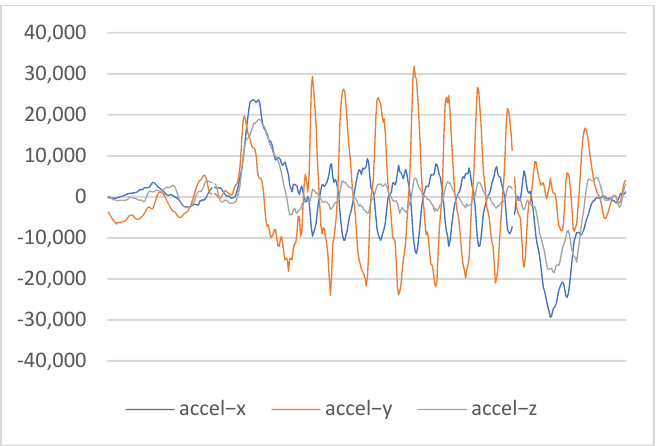
Figure 6. Eye rubbing accelerometer data.